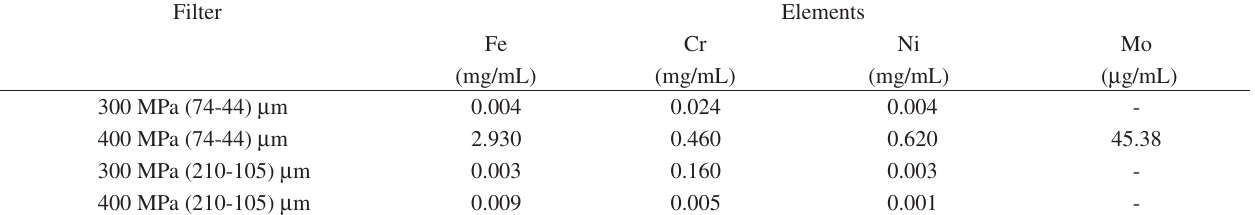
SO solution, during 180 hours. Results obtained by atomic absorption spec- 2 4